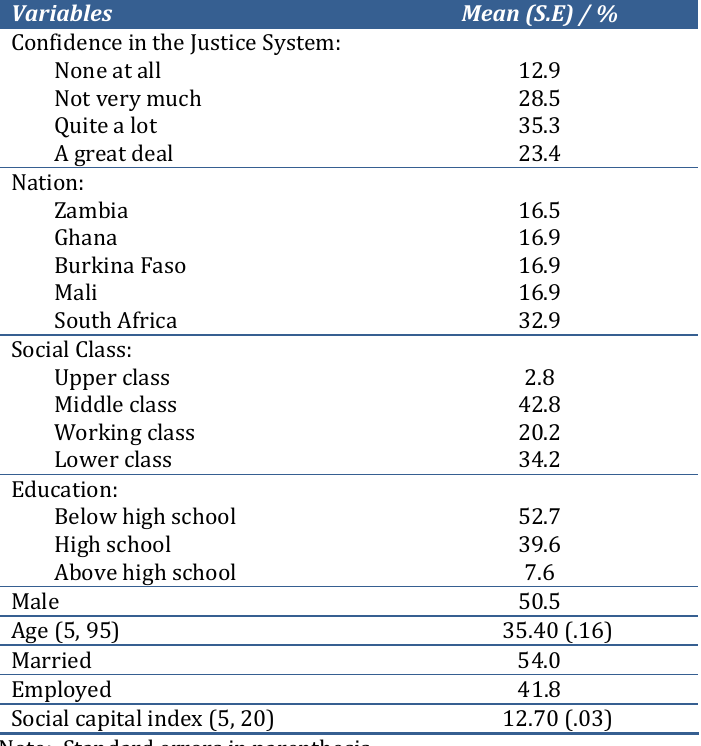
Table 1: Frequency distribution of variables used in the study (N = 9090) Variables Mean (S.E) /